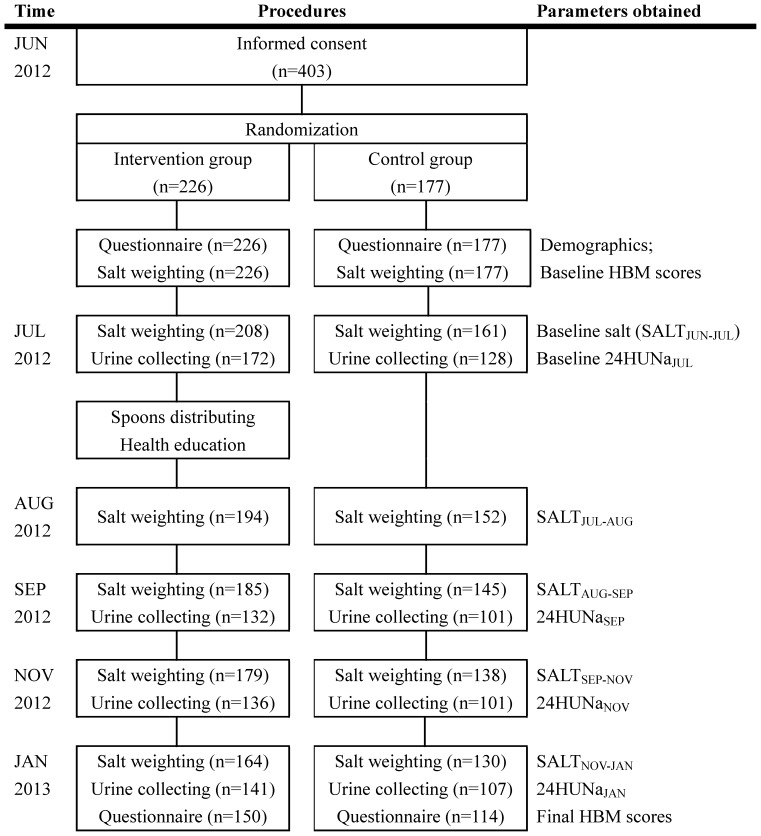
Study flow diagram.